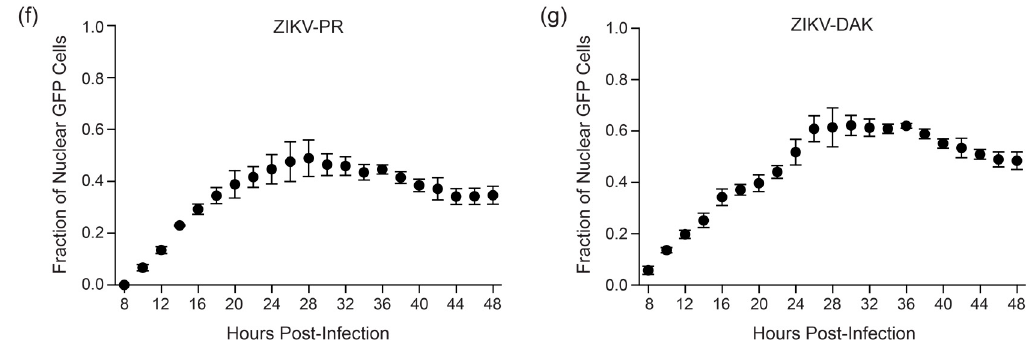
Figure 4. Kinetics of nuclear localization of GFP following ZIKV infection. ( a – c ) Fluorescence microscopy shows sequential images of the same field of A549 cells stably expressing ZIKV-NLS-GFP after infection (MOI 10) with mock ( a ), ZIKV-PR ( b ) or ZIKV-DAK ( c ) at the indicated hours post infection (hpi) above each image. Red, bolded time points represent the first time at which nuclear GFP could be detected. Arrows mark the cell of interest and asterisks indicate cells with nuclear GFP. Scale bar, 10 µ m. ( d , e ) Immunoblot analysis of extracts from A549 cells stably expressing the ZIKV-NLS-GFP reporter that were mock-infected or infected with ZIKV-PR (MOI 10) ( d ), or ZIKV-DAK (MOI 10) ( e ) for the indicated hours (hpi). Arrows mark full-length (FL) or cleaved (C) ZIKV-NLS-GFP, with both light and dark exposures of indicated blots shown. ( f , g ) Quantification of the experiments in ( b , c ) in which the number of cells positive for ZIKV in a field were identified by determining the incidence of GFP nuclear translocation in each cell at various time points following ZIKV infection. Fractions represent the number of cells with nuclear GFP over the total number of fluorescent cells in a field. Values represent the mean ± SEM ( n = 5 fields) from three independent experiments, with >20 cells counted per field.